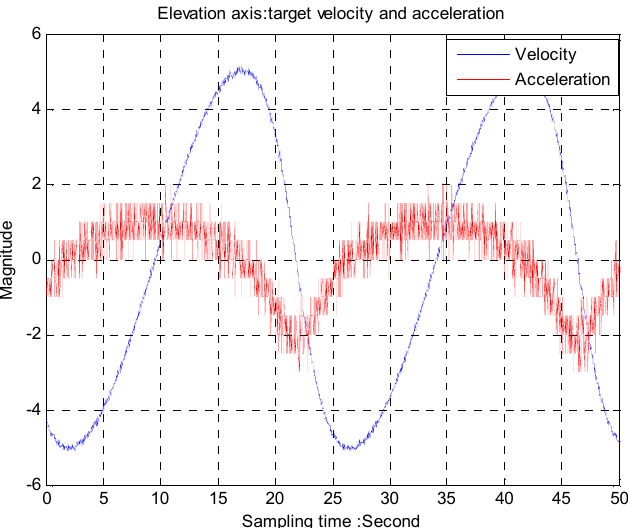
Figure 10. Elevation axis: target velocity and acceleration.